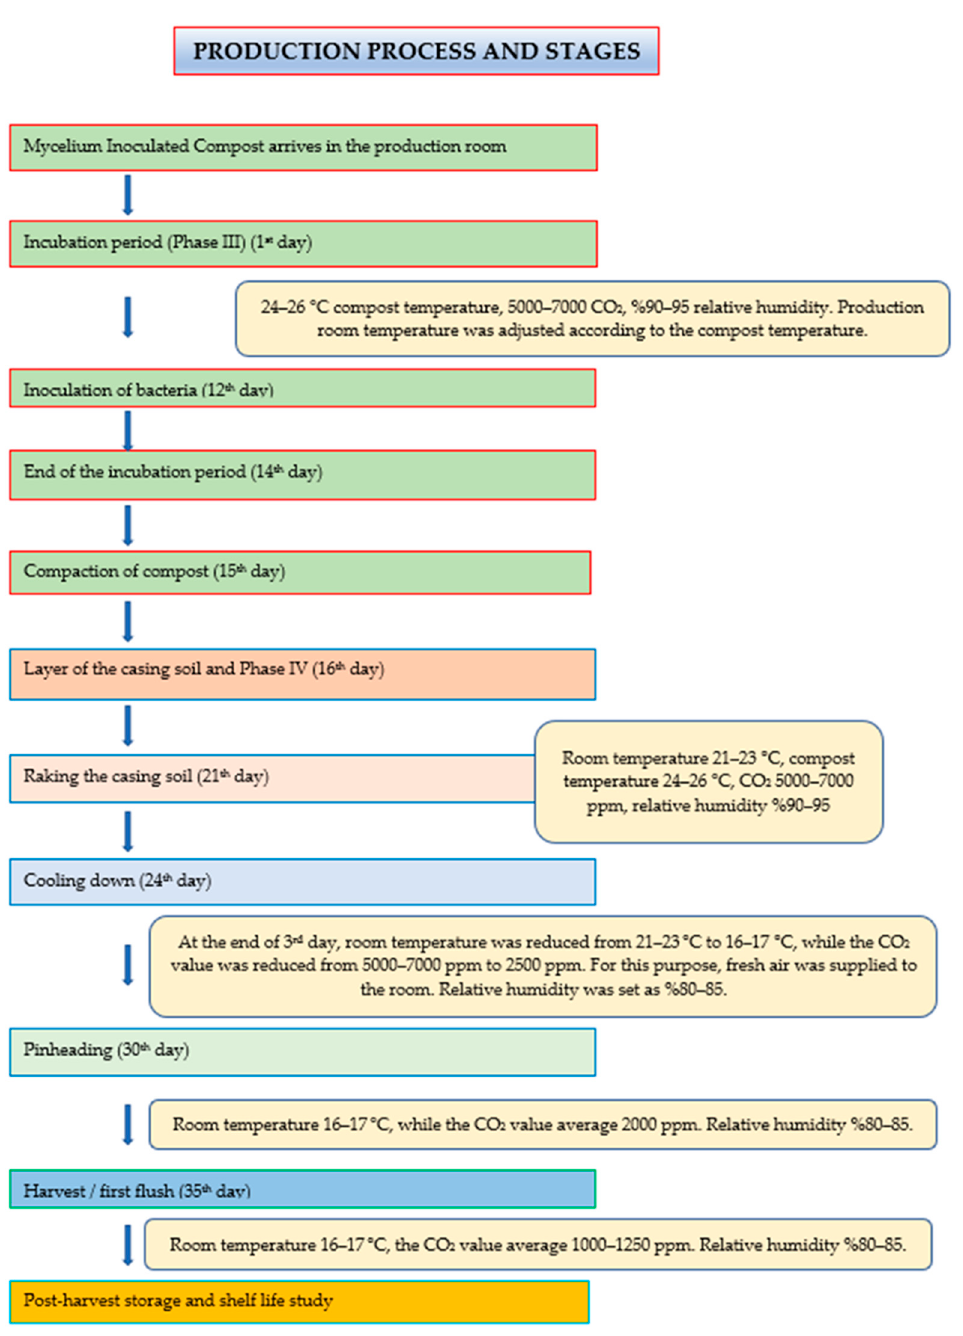
Figure 1. Production stages of Agaricus bisporus L.